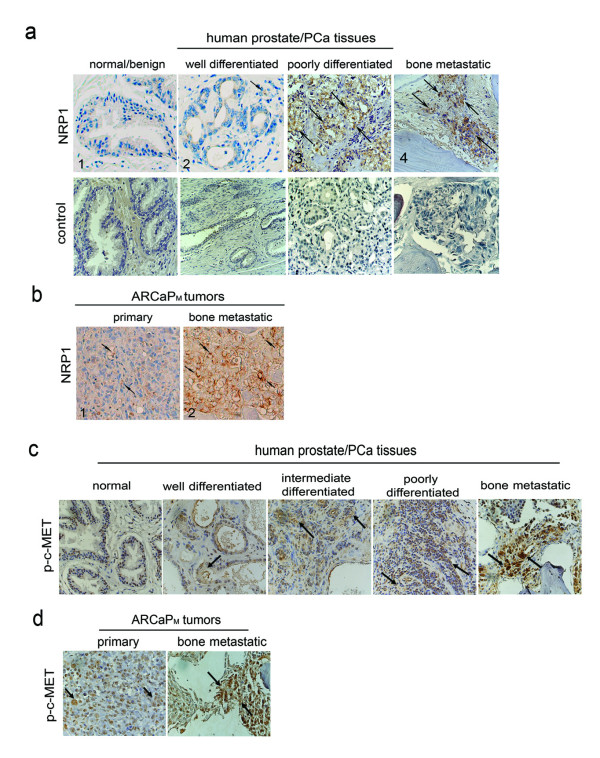
Expression of NRP1 and p-c-MET is associated with bone metastatic status of human PCa specimens and the ARCaPM model. IHC analyses of NRP1 expression in human normal/benign, cancerous and metastatic prostatic tissue specimens (a) and primary and bone metastatic tissue specimens from ARCaPM model (b), and of p-c-MET expression in human PCa progression (c) and ARCaPM xenografts (d). Arrows indicate positively-stained cells.